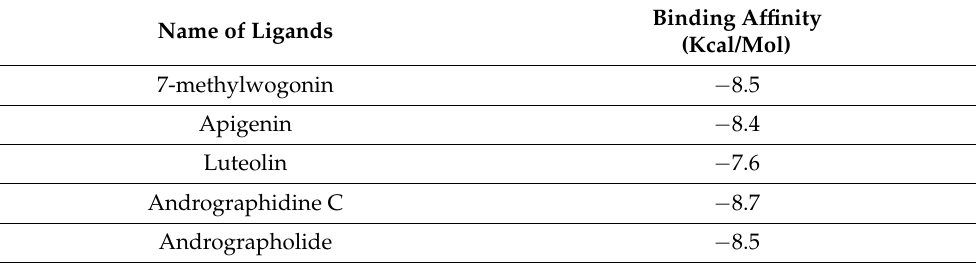
Table 1. Binding affinities of